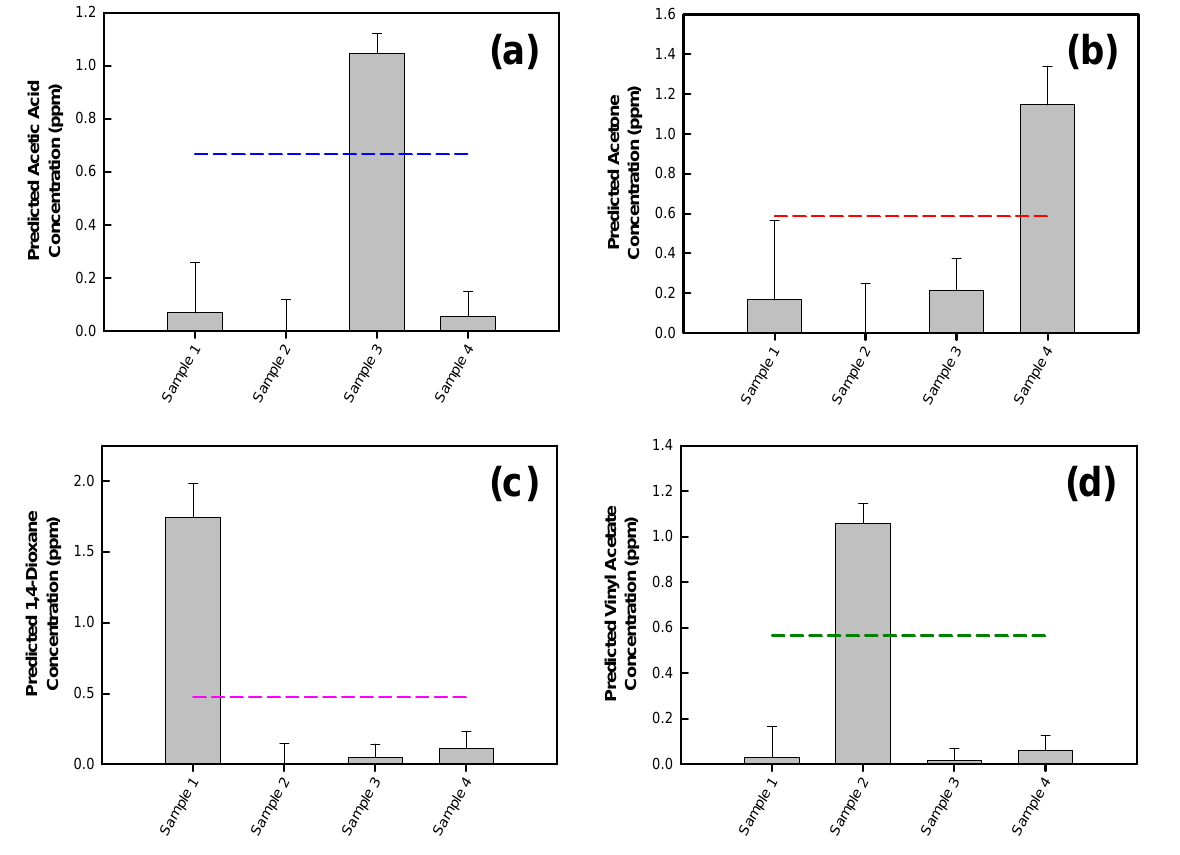
Figure 11. Identification of validation samples using (a) acetic acid-specific algorithm; (b) acetone-specific algorithm; (c) 1,4-dioxane-specific algorithm; and (d) vinyl acetate- specific algorithm. Classification for each analyte is based on four PCs. The threshold concentration for each analyte is represented by a dotted